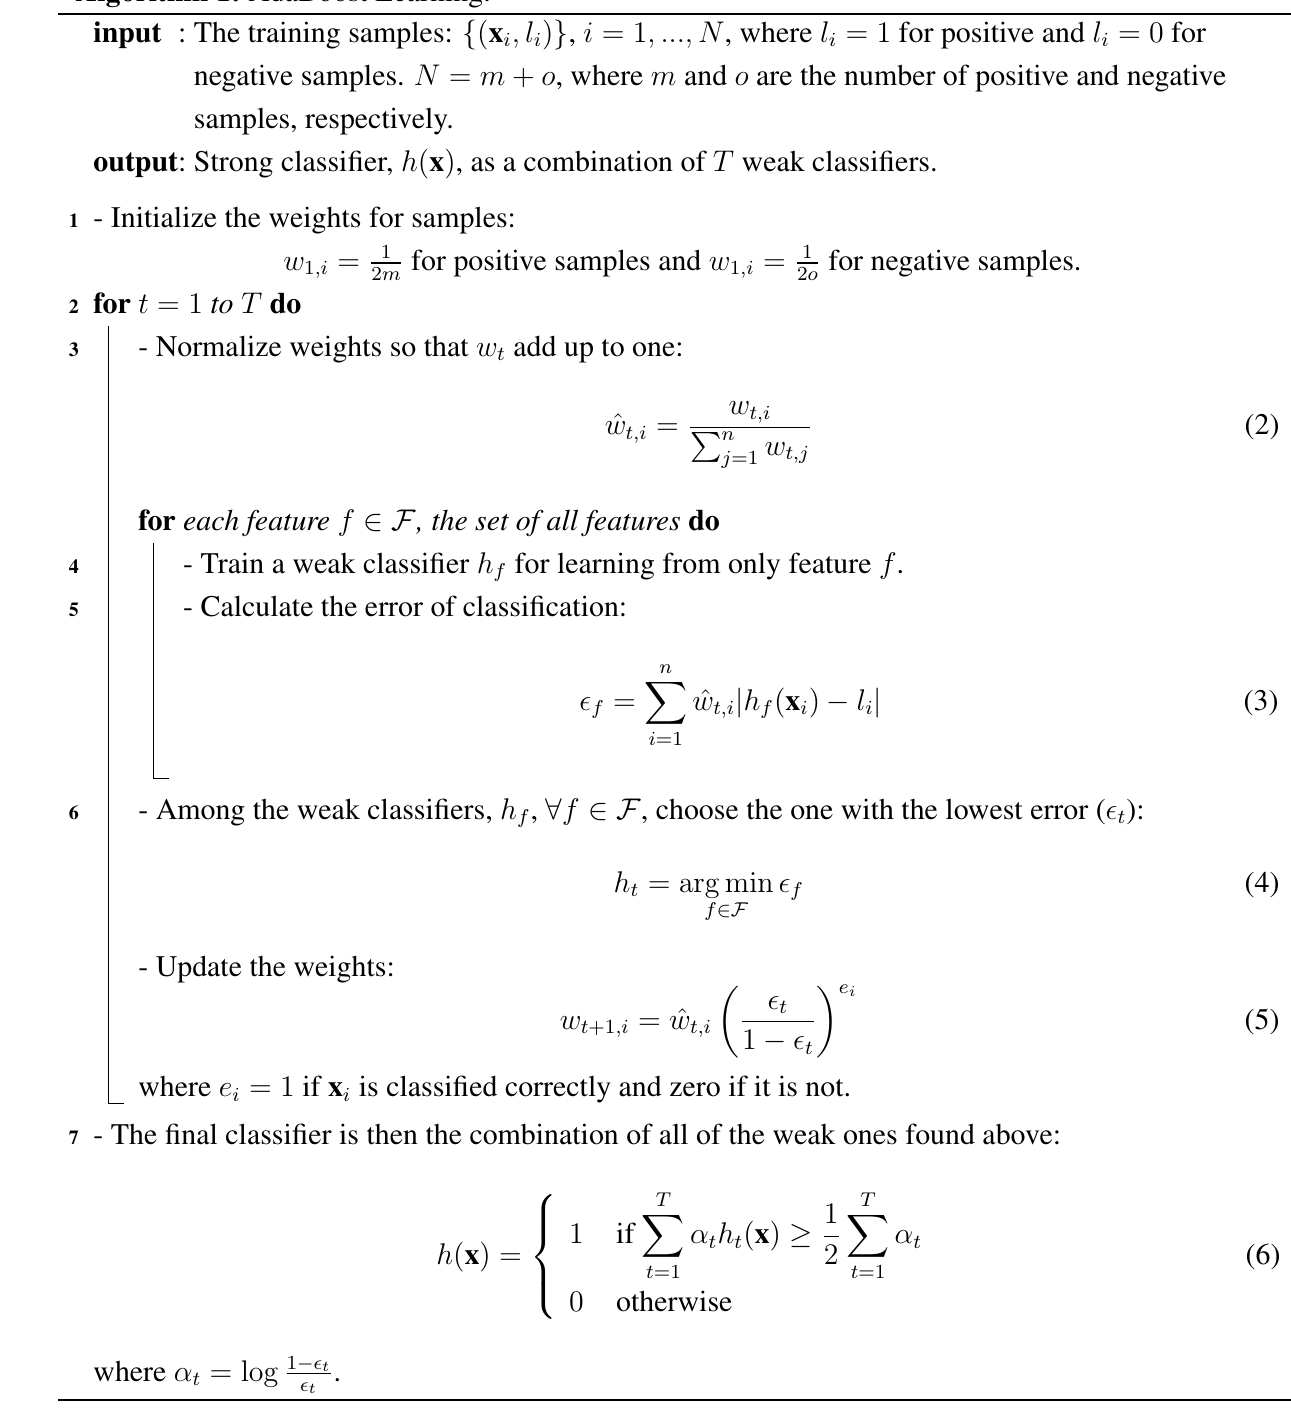
Algorithm 1: AdaBoost